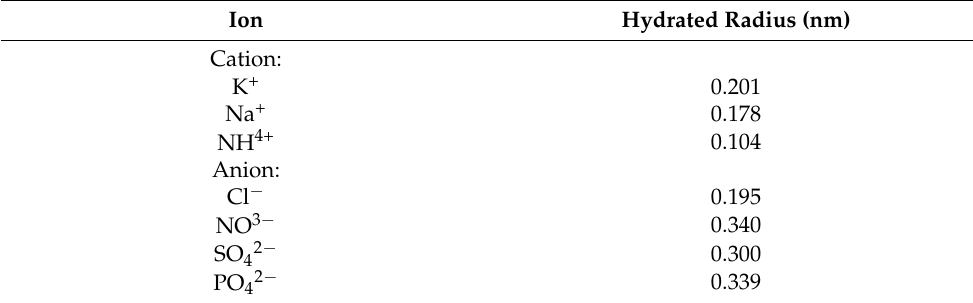
Table 7. Hydrated radius of ionic species involved in this study, adapted from Ref. [31]. Ion Hydrated Radius (nm) Cation: K + 0.201 Na +